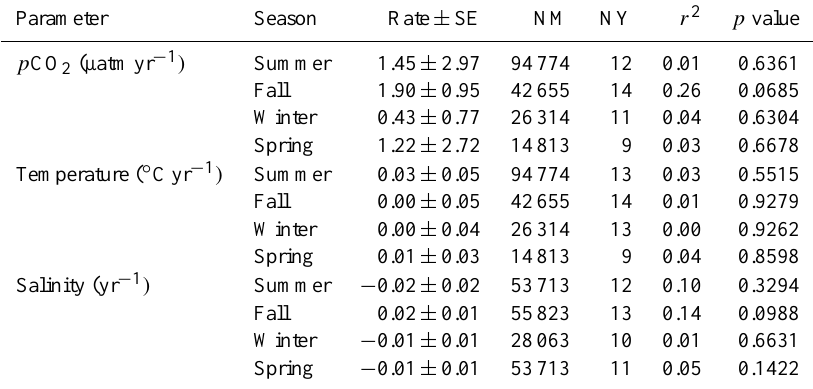
Table 3. Trend analysis (1999–2013) of Lamont-Doherty Earth Observatory of Columbia University (LDEO) surface continuous underway p CO 2 (µatm), salinity, and temperature ( ◦ C) measurements from within the central subregion of the Palmer-Long Term Ecological Research (PAL-LTER) sampling grid (Fig. 1, red box). Regression statistics include mean rate, standard error (SE), number of measurements (NM), number of years (NY), r -squared, and p value. Trends with a p value <0.05 would be considered statistically significant at the 95% confidence